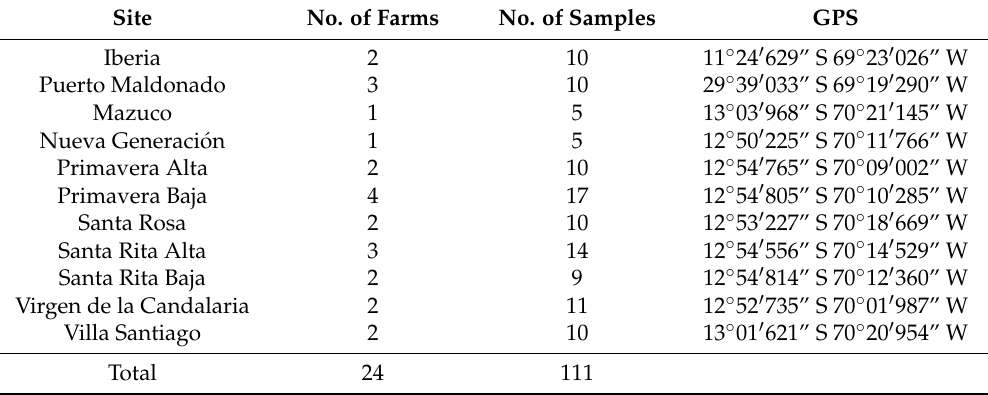
Table 2. Characteristics of 24 study sites for Piaractus brachypomus (Paco) sample collection in the Madre de Dios river basin of Southeastern